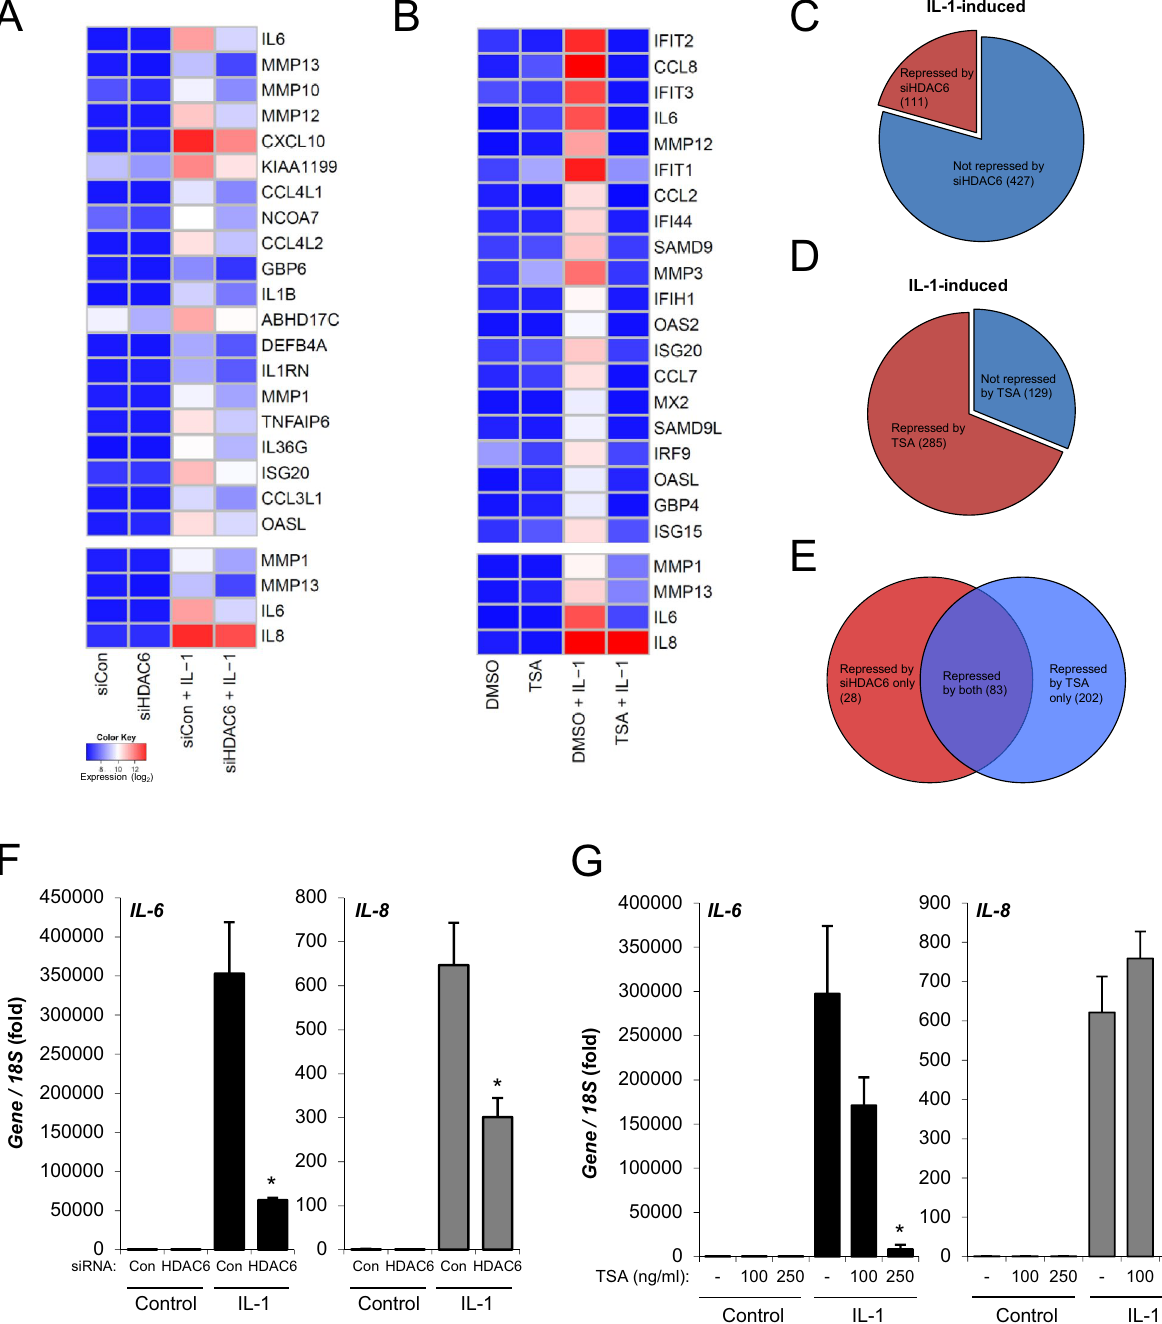
Figure 2. Effect of HDAC6 depletion and TSA on gene expression in SW1353 cells. SW1353 cells were stimulated with IL-1 for 8 h in the presence of HDAC6 siRNA or TSA (250 ng/ml). ( A – E ) RNA was extracted and gene expression profiled by whole-genome microarray. ( A , B ) Heatmap representation of the IL-1 induced genes most repressed by ( A ) HDAC6 depletion in duplicate or ( B ) TSA treatment in singlicate. The expression of MMP1 , MMP13 , IL6 and IL8 is provided below each heatmap for comparison. C-E. Venn diagrams representing the proportion of IL-1-induced genes (> 1.5-fold) repressed 1.5-fold by ( C ) HDAC6 depletion, ( D ) TSA treatment, or ( E ) both HDAC6 depletion and TSA. ( F,G ). SW1353 cells were stimulated with IL-1 for 8 h in the presence of ( F ) HDAC6 siRNA or ( G ) TSA at the indicated concentrations. RNA was extracted and expression of IL6 and IL8 measured by real-time RT-PCR. D-E were performed in triplicate. Data are presented as fold induction relative to the basal expression and represent mean ± S.D. (* p < 0.05). Data are representative of a minimum of three independent